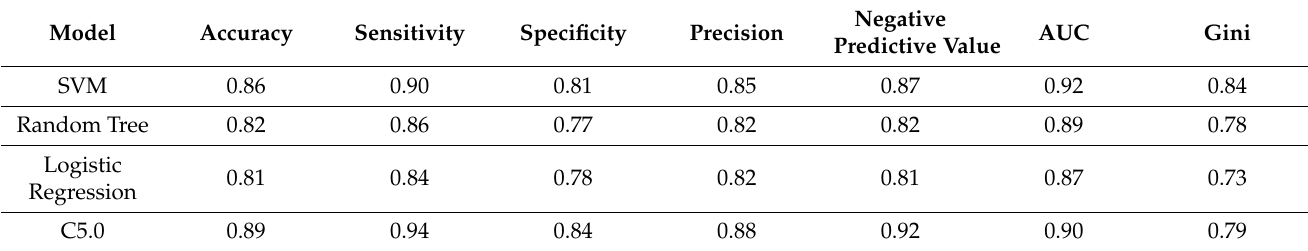
Table 2. Results of the classification performance of different machine-learning models using the walking dataset. Model